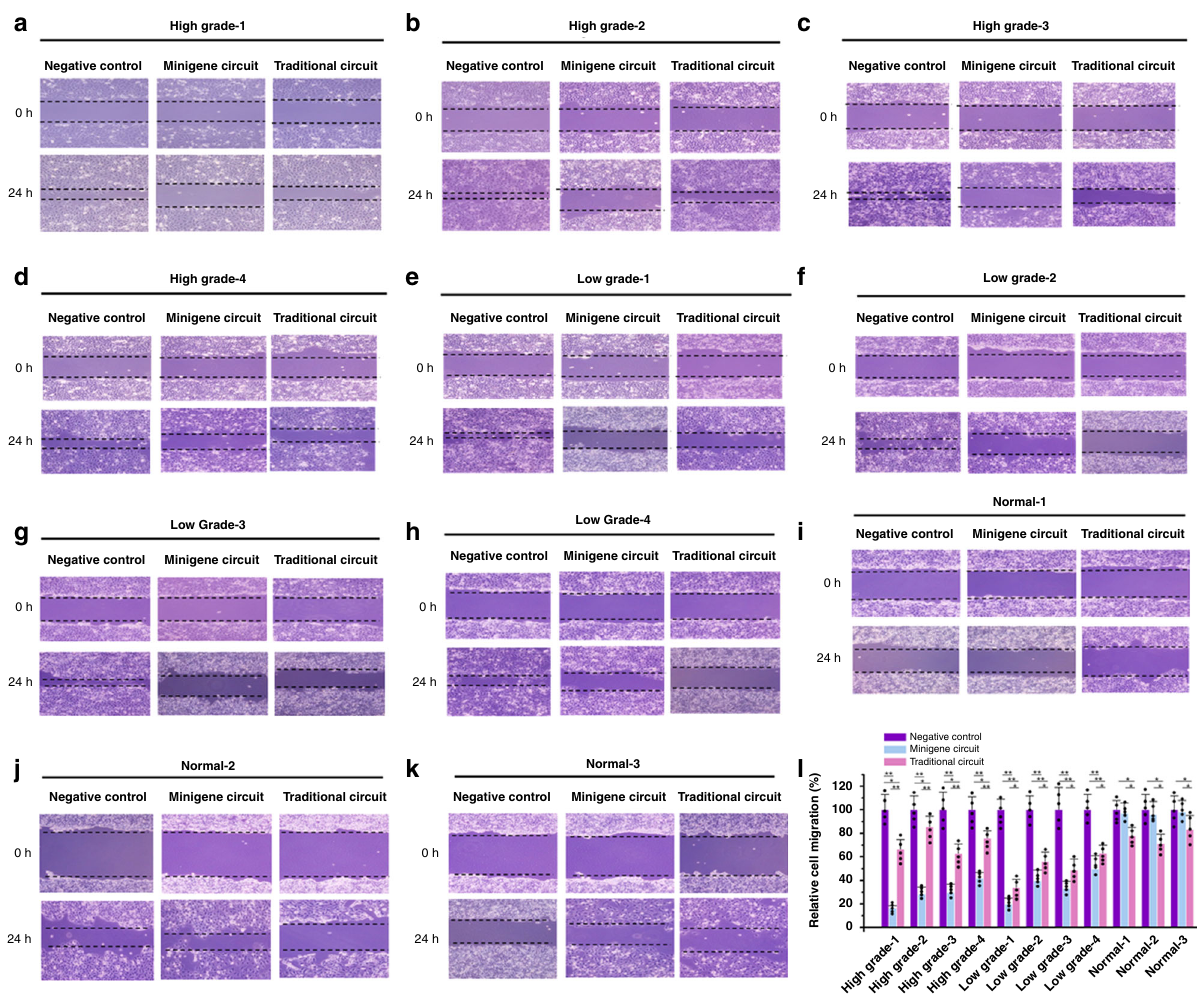
Fig. 4 Migrations of bladder cell lines transfected with either the minigene or traditional circuits. Migrations of the transfected cells “ high grade-1 ” ( a ), “ high grade-2 ” ( b ), “ high grade-3 ” ( c ), “ high grade-4 ” ( d ), “ low grade-1 ” ( e ), “ low grade-2 ” ( f ), “ low grade-3 ” ( g ), “ low grade-4 ” ( h ), “ normal-1 ” ( i ), “ normal-2 ” ( j ), and “ normal-3 ” ( k ) were measured using the scratch assay. Data are expressed as the mean ± SD ( l ). The minigene circuit without output gene was used as the negative control. Relative cell migration (%) in each group was determined by the migration distance normalized to that of the negative control group. Each experiment was independently performed in triplicate fi ve times. Each error bar indicates the variation between the means of fi ve independent experiments. The small black dots represent the mean of each independent experiment. * p < 0.05 and ** p < 0.01, between the groups, using a two-tailed t -test. Exact p- values for asterisks (from left to right): 0.0033, 0.027, 0.0087, 0.0042, 0.045, 0.0081, 0.0043, 0.025, 0.0096, 0.0052, 0.031, 0.0093, 0.0036, 0.0045, 0.043, 0.0049, 0.0068, 0.042, 0.0043, 0.0062, 0.044, 0.0054, 0.0074, 0.046, 0.021, 0.033, 0.017, 0.029, 0.024, and 0.036. Source data are provided as a Source Data fi